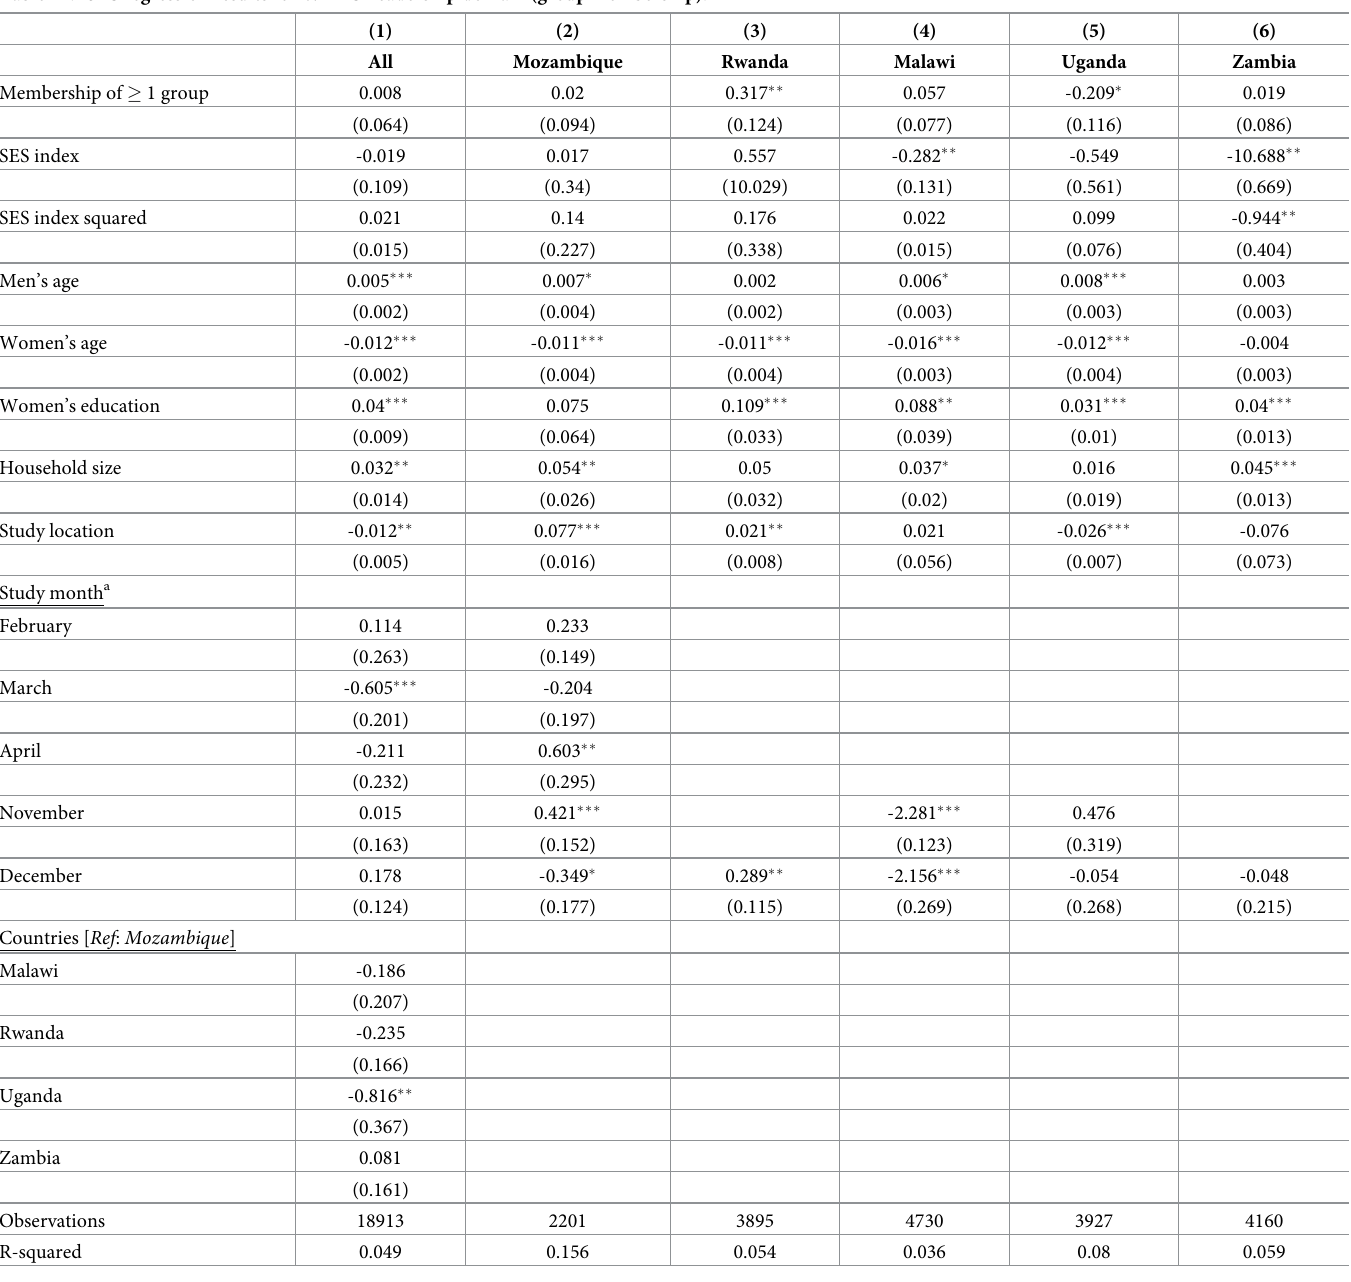
Table 11. OLS regression results for WDDS–leadership domain (group